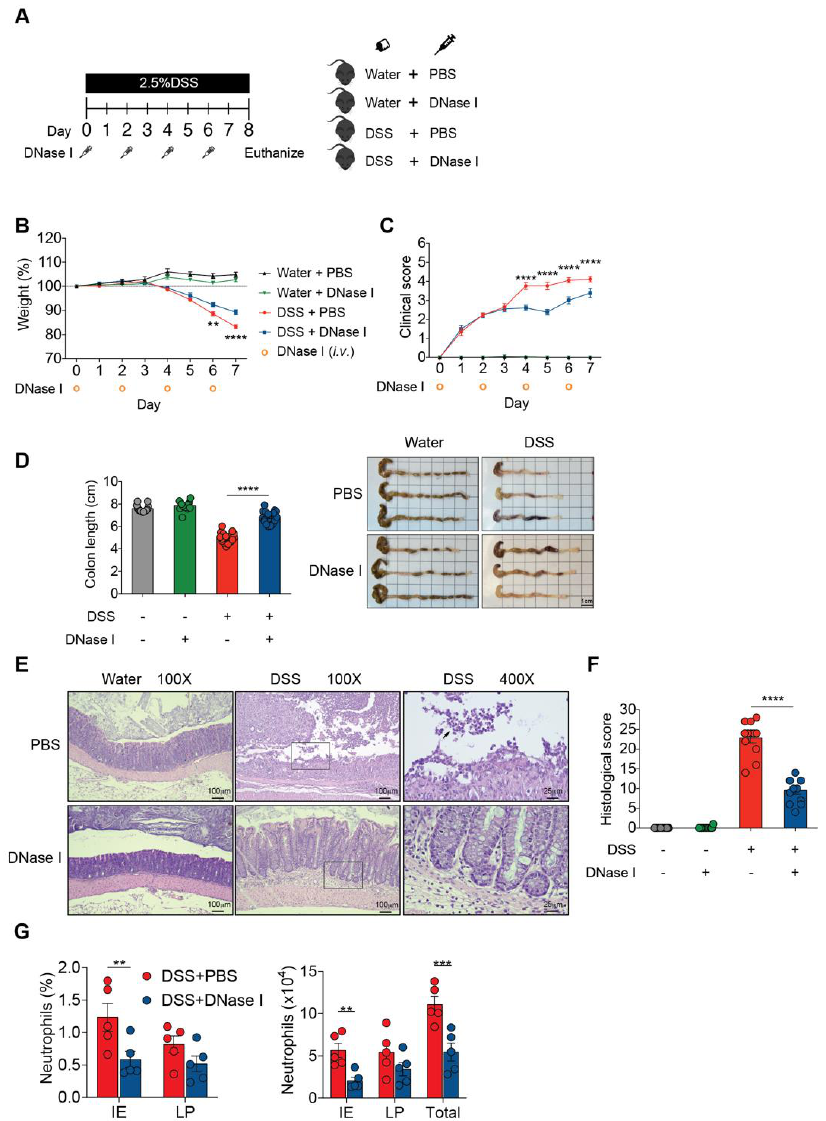
Figure 2. DNase I treatment attenuates DSS-induced colitis in mice. ( A ) Schematic overview of the experiment. Colitis was induced by providing 2.5% DSS in the drinking water for 8 d. Clean water was fed to the controls. Phosphate-buffered saline (PBS) or 250 U/dose DNase I was intravenously ( i.v. ) administered to wild-type C57BL/6 mice every other day, on days 0, 2, 4, and 6. ( B , C ) Daily weight and total clinical scores of the control or DSS-treated mice after PBS or DNase I treatment. ( D ) Colon lengths and representative colon images of the control or DSS-treated mice with or without DNase I treatment. ( B – D ) The results are pooled data from four separate experiments. n = 15 mice per control groups and n = 18 mice per DSS groups. ( E ) Representative hematoxylin and eosin (H&E) staining of the colon, 400X high-power field (HPF) images are the enlargement of the area outlined in the 100X HPF images. The black arrow indicates neutrophils in the lumen. ( F ) Histopathology score of the control or DSS-treated mice with or without DNase I treatment. ( E,F ) The results are pooled data from two separate experiments. n = 9 mice per control groups and n = 12 mice per DSS groups. ( G ) Percentage and absolute numbers of neutrophils (CD11b + Ly6G + F4/80 - ) in the intestinal epithelium (IE) and lamina propria (LP) of the colon (Total). n = 5 mice per group. The data represent the mean ± SEM. Statistical analyses were performed using ( B – D , F ), one-way ANOVA with Turkey’s multiple comparison or ( G ), an unpaired two-tailed t -test. ** p < 0.01, *** p < 0.001, **** p < 0.0001. Scale bar, 1 cm in ( D ), 100 µm in 100× pictures and 25 µm in 400× pictures of ( E ).